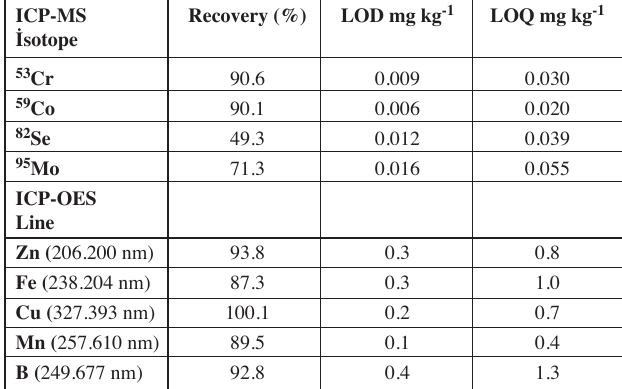
Tab. 2: Performance characteristic of mineral determination